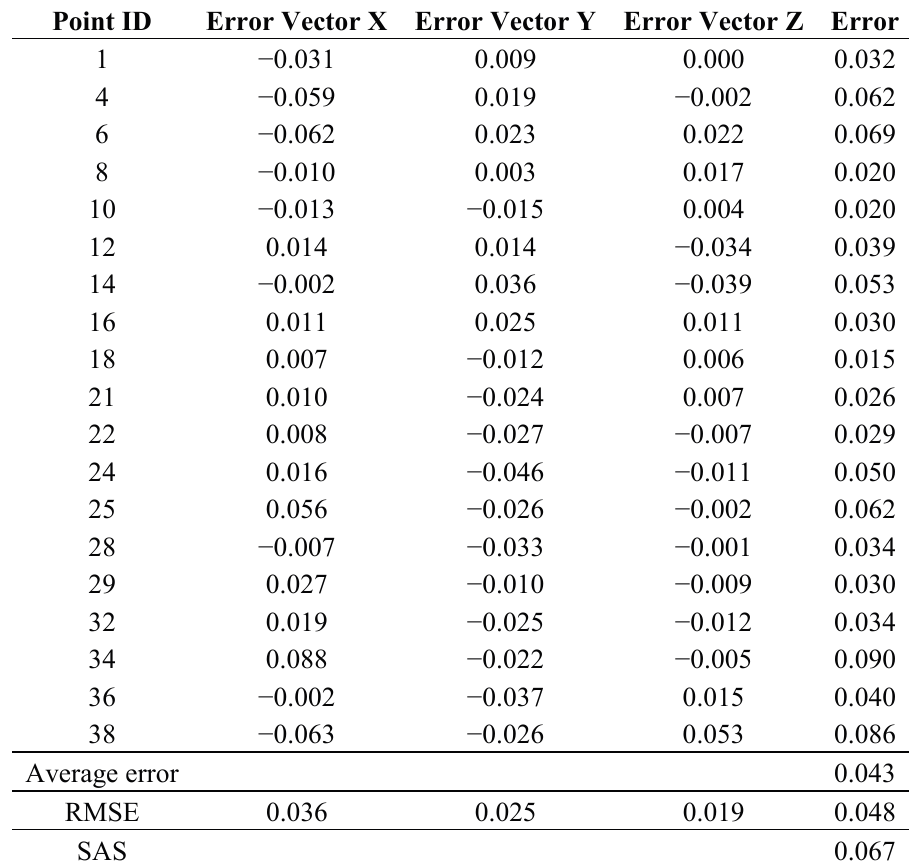
Table 2. Accuracy assessment results for point-cloud data of the corridor (unit: